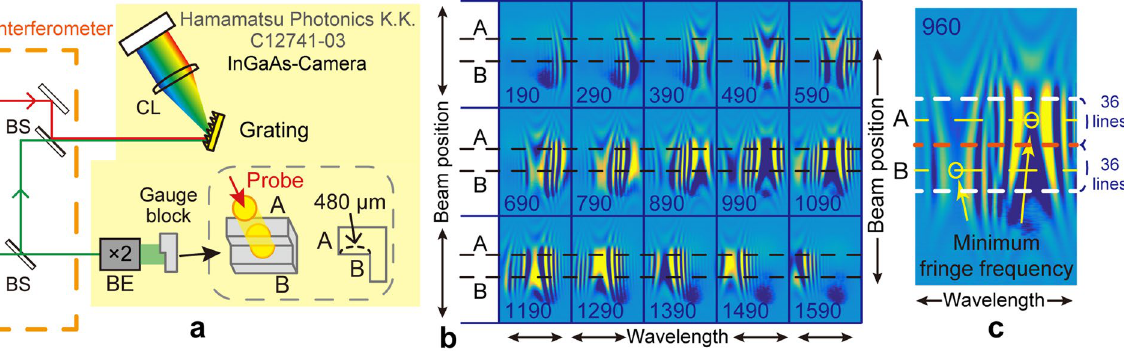
Figure 4. Schematic of the step measurement and captured images. ( a ) Experimental setup for the step measurement. Interferometer setup is shared with setup shown in Fig. 2a. BE: beam expander and CL: cylindrical lens. Grating: diffraction grating, 600 line/mm. ( b ) Captured spectral interferometric images by InGaAs camera at each delay position (number in each image, in µ m unit). The images were processed so that the contrast was enhanced, and the horizontal and vertical directions of each image represent the wavelength and beam positions. Black dashed lines in each image are guide for eyes indicating area of steps A and B. ( c ) Zoomed image is at a delay position of 960 µ m. To obtain longitudinal heights for steps A and B, 36 horizontal cross-sectional lines between upper and bottom white lines and central red dashed line were analysed. Horizontal yellow dashed lines indicate central area in the regions of steps A and B.